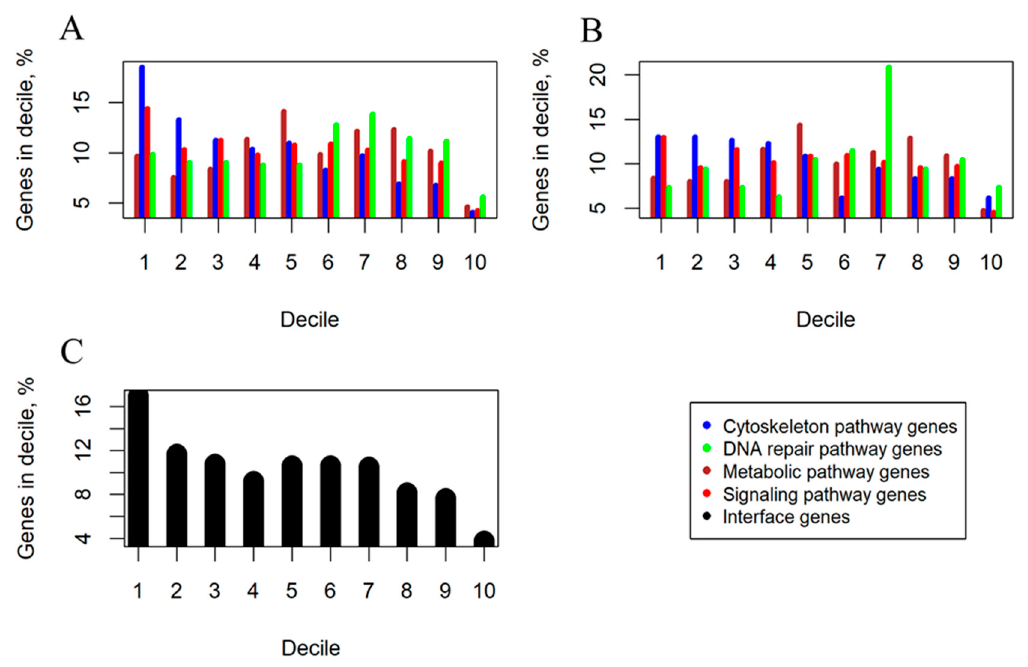
Figure 2. Decile analysis of cancer-associated mutations (deciles ordered from high gene mutation rate on the left to low on the right). ( A ) Percentage shares of genes belonging to signaling, metabolic, cytoskeleton, DNA repair pathway functional groups. ( B ) Percentage shares of pathway group-specific, non-overlapping genes. ( C ) Percentage shares of genes present in two or more functional groups of molecular pathways (termed interface genes).